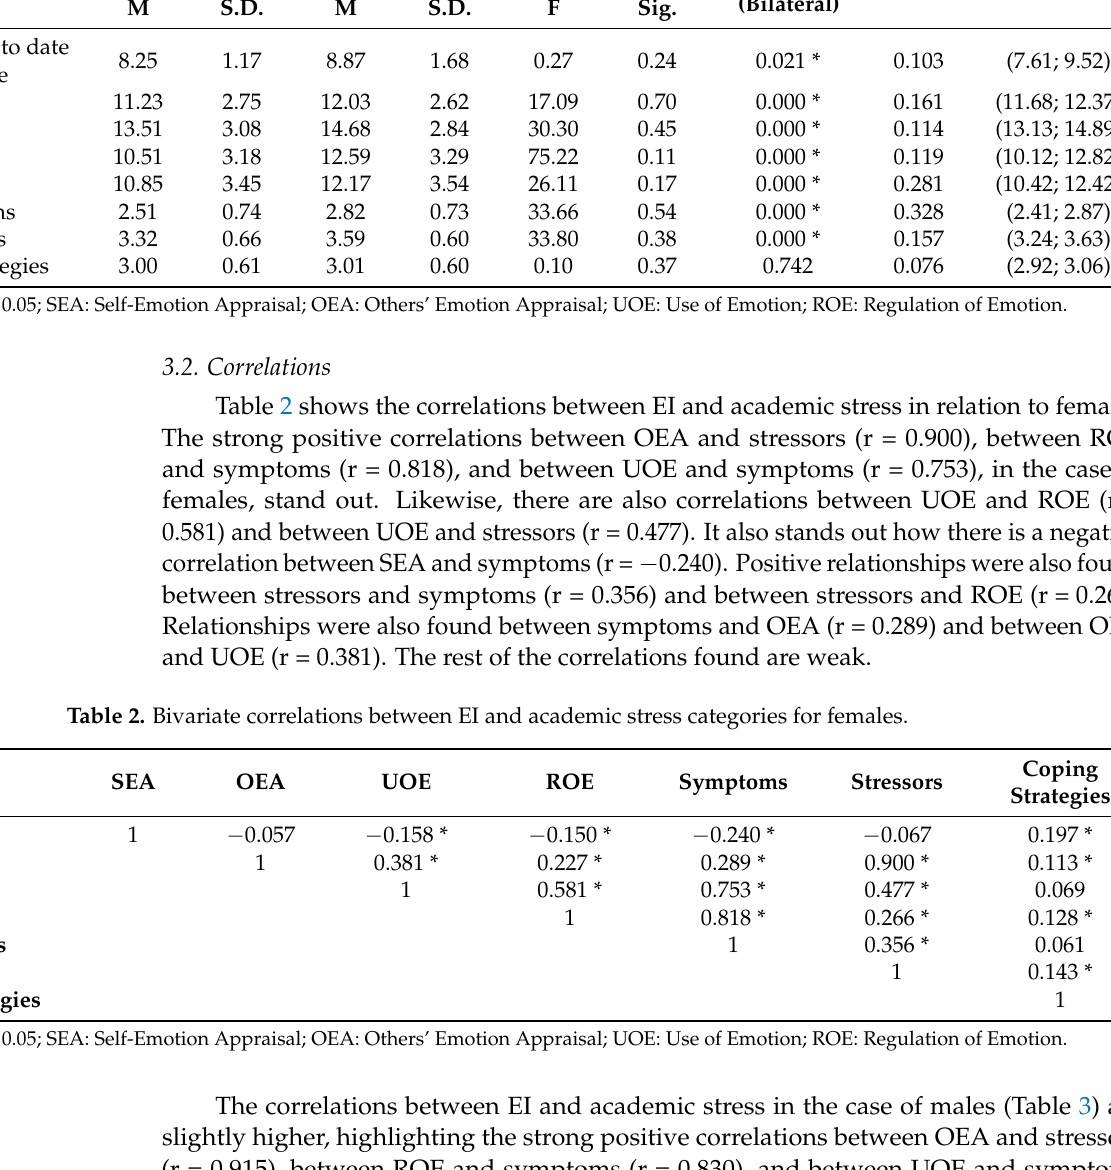
Coping Symptoms Stressors